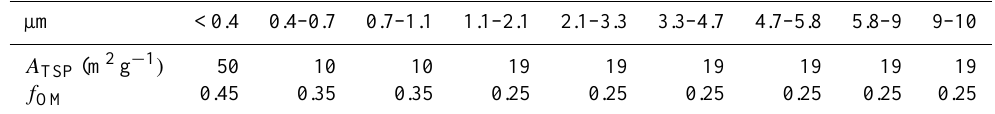
Table 2. A TSP and f OM adopted from Yu and Yu (2012).